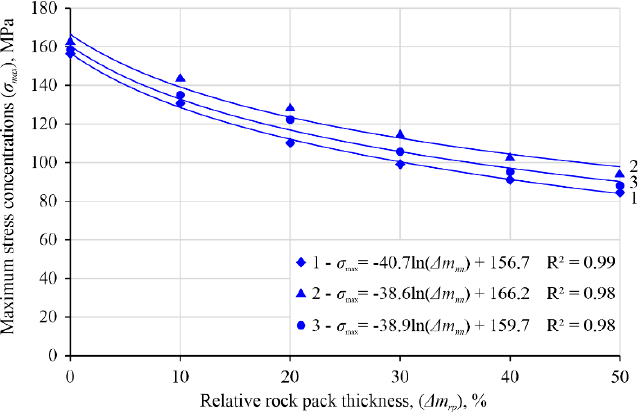
Figure 6. Dependence of a change in the maximum stress concentrations of rock layers in the frontal bearing pressure zone on the relative rock pack thickness: 1—sandstone ( y = 45 m); 2—siltstone ( y = 42 m); 3—argillite ( y = 29 m).